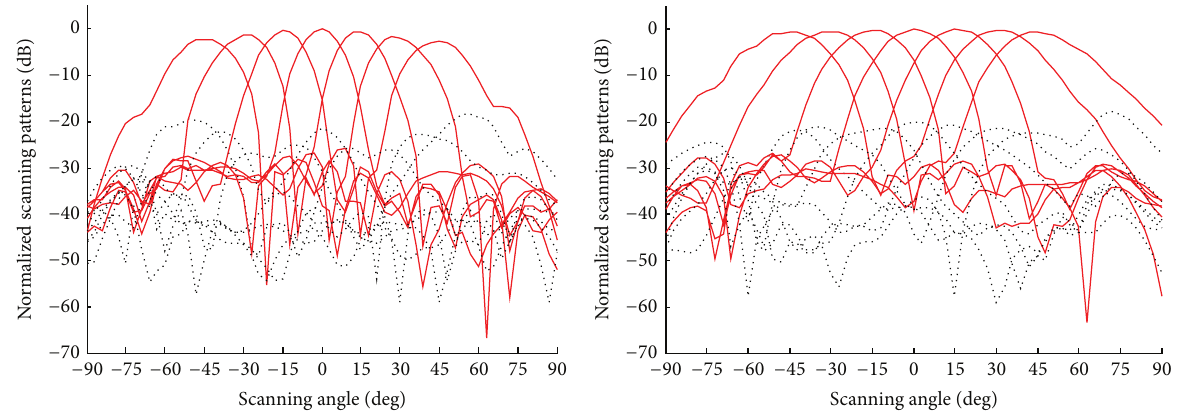
(b) Radiation pattern of the TCDA-IB array at ± 45, ± 30, ± 15, and 0deg from broadside at 1.8GHz